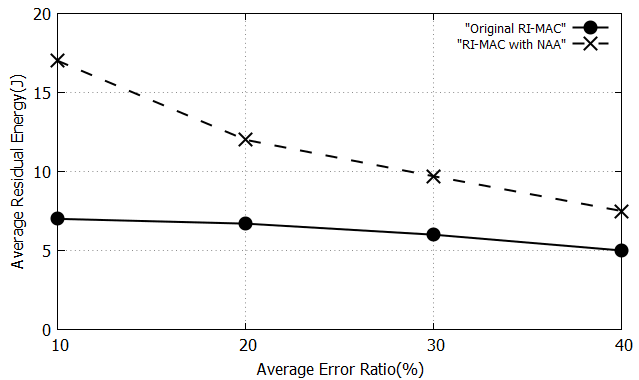
Figure 6. Energy efficiency according to Average Loss